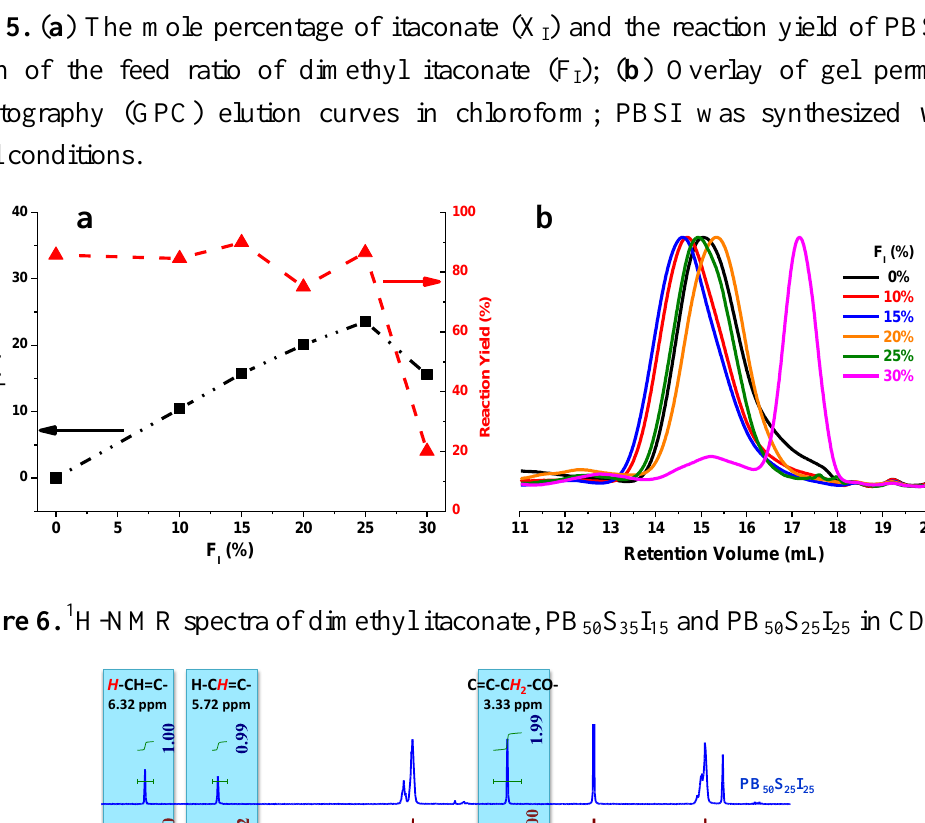
) and the reaction yield of PBSI as a I ); ( b ) Overlay of gel permeation I